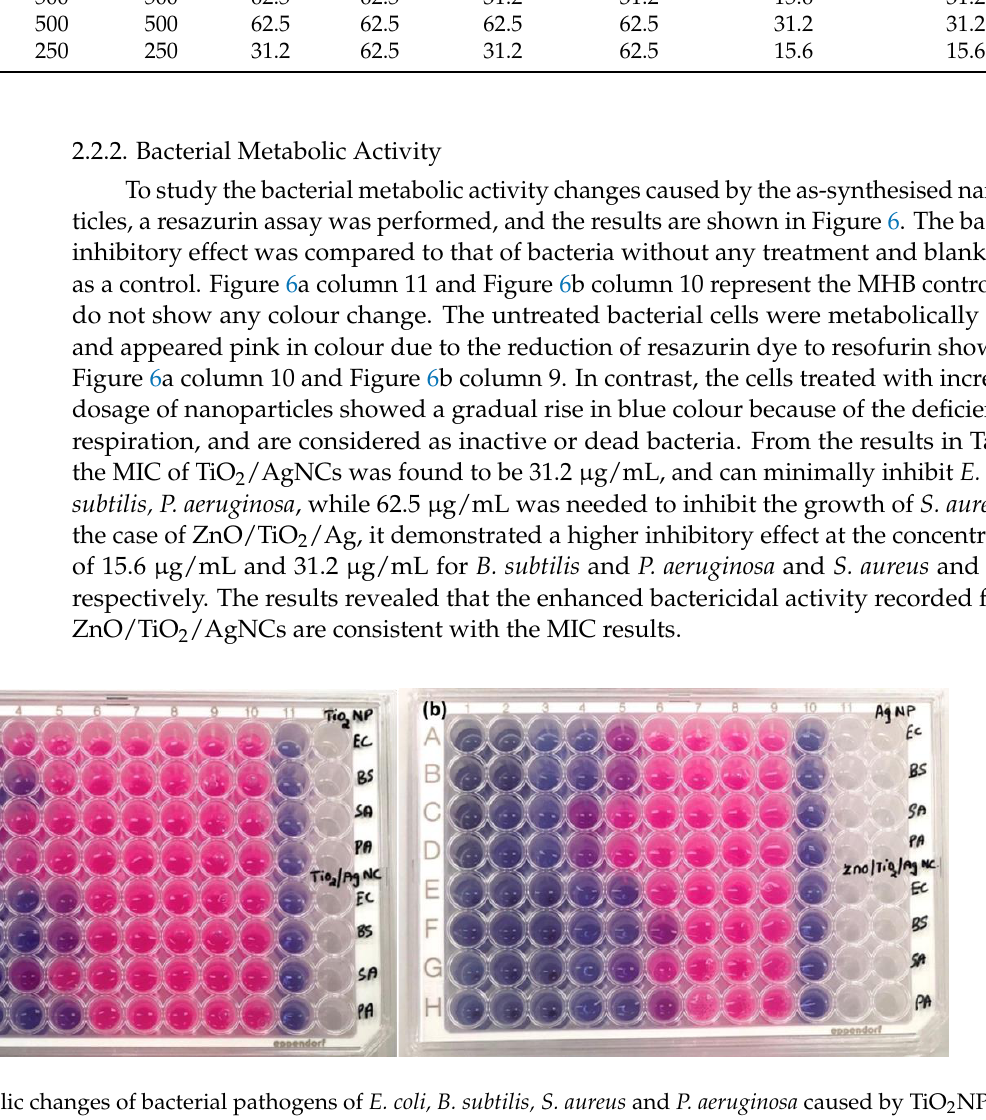
Table 1. MIC and Minimum Bactericidal Concentration (MBC) of TiO 2 NPs, AgNPs, TiO 2 /AgNCs and ZnO/TiO 2 /AgNCs, determined by broth microdilution assay against bacterial pathogens. Bacterial Strains